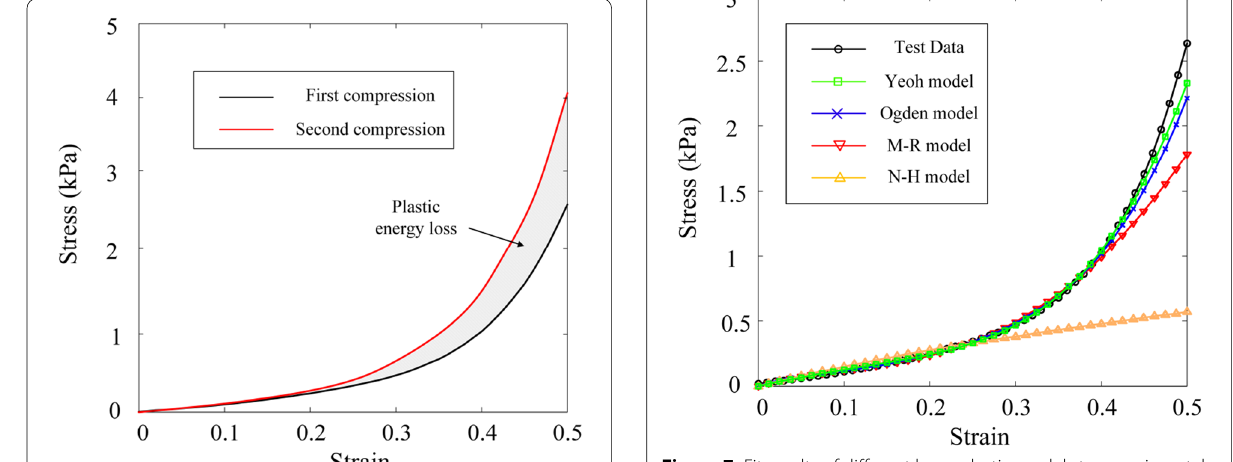
Figure 7 Fit results of different hyperelastic models to experimental